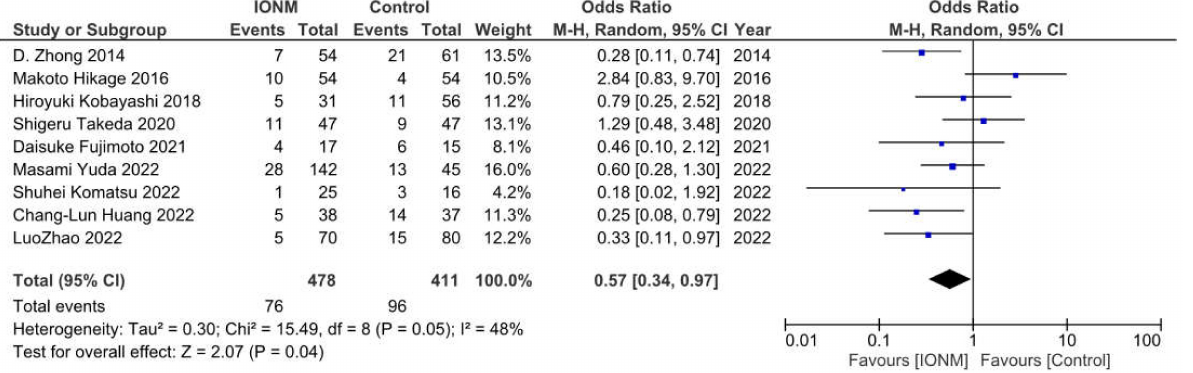
Figure 5. Forest plot of IONM for pneumonia. Abbreviations: IONM—intraoperative